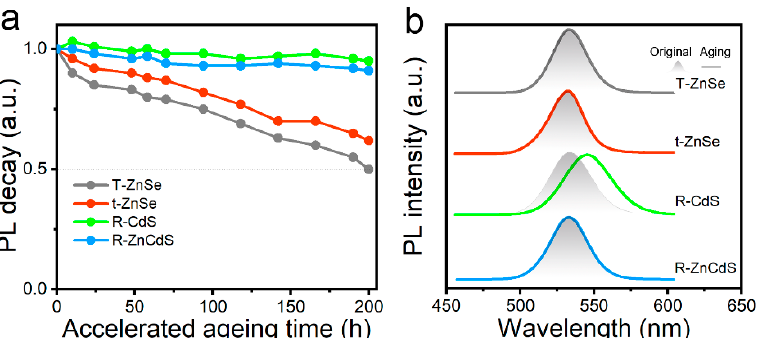
Figure 3. ( a ) PL intensity decay of R-CdS, T-ZnSe, t-ZnSe and R-ZnCdS quantum dots under UV light irradiation. ( b ) Comparison of spectral profiles of accelerated aging quantum dots and original spectra.